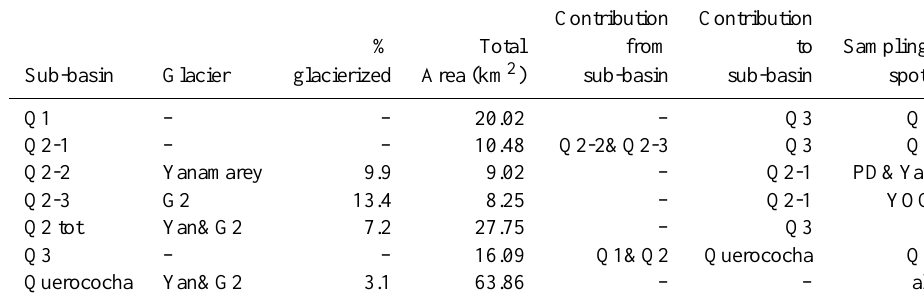
Table 1. Geospatial characteristics of the Querococha watershed and sub-basins. Contribution Contribution % Total from to Sampling Sub-basin Glacier glacierized Area (km 2 ) sub-basin sub-basin spots